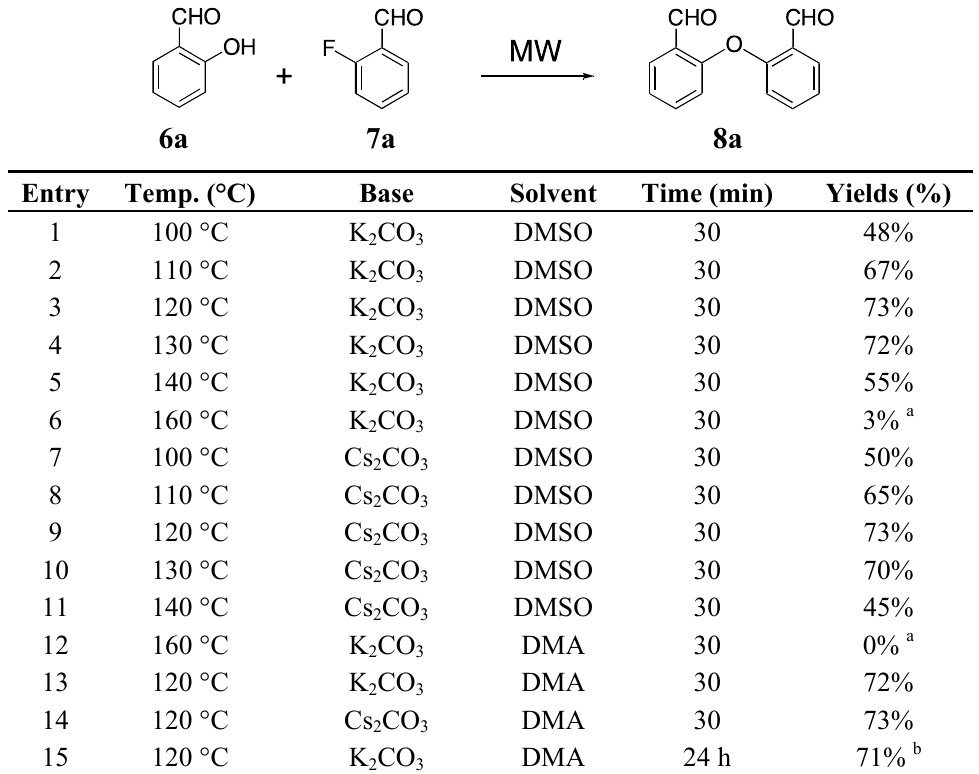
Table 1. Optimization of microwave-induced synthesis of 2,2'-oxybis(benzaldehyde) 8a